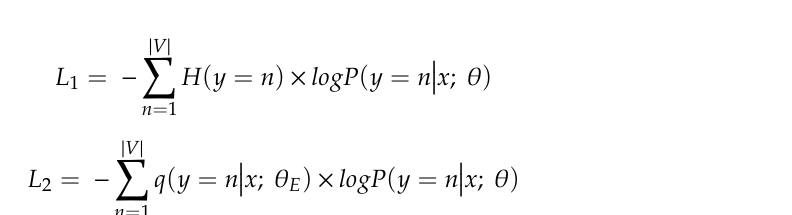
Figure 12. Face area detection time (in milliseconds).